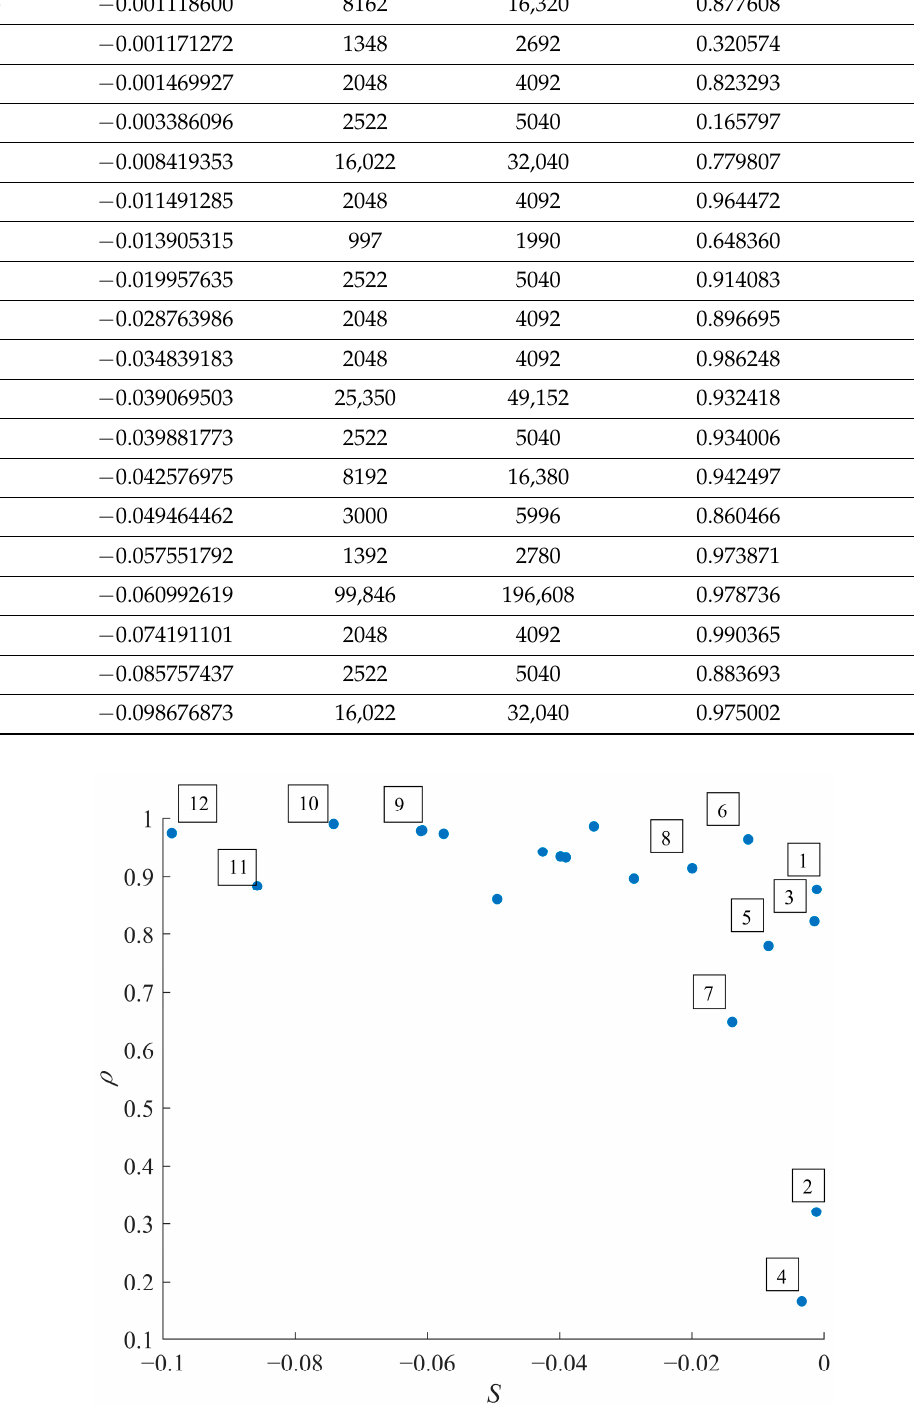
( d ) Figure 13. Polyhedral models corresponding to points 1–4 in Figure 12. ( a ) 52,760 (1998 ML 14 ). ( b ) 101,955 Bennu. ( c ) 1998 KY 26 . ( d ) 4 Vesta.